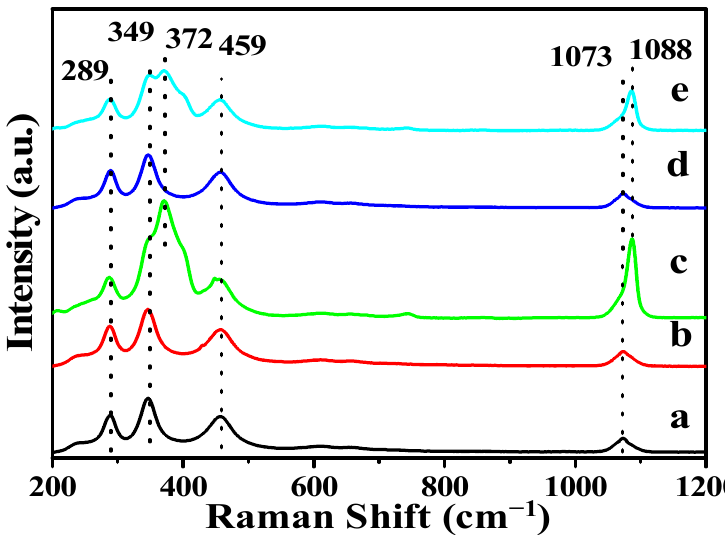
Figure 2. Raman spectra of the La 2 O 3 and X-La 2 O 3 catalysts. ( a ) La 2 O 3 ; ( b ) Li-La 2 O 3 ; ( c ) Mg-La 2 O 3 ; ( d ) Zn-La 2 O 3 ; ( e ) Ce-La 2 O 3 .